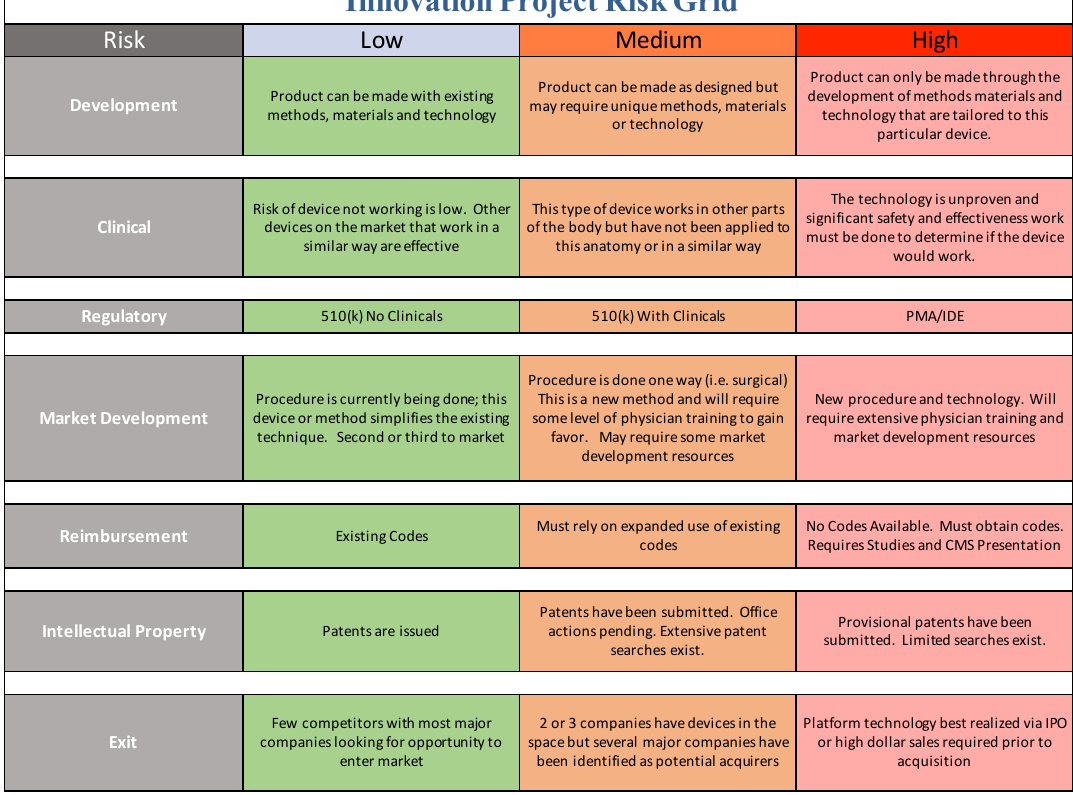
Figure 4. Medical device innovation project risk grid. This outlines the risks of any medical device project from prospective investor and co-development partner. Drug and diagnostic risk grids overlap the medical device risk grid categories but may include additional categories beyond the scope of discussion of this